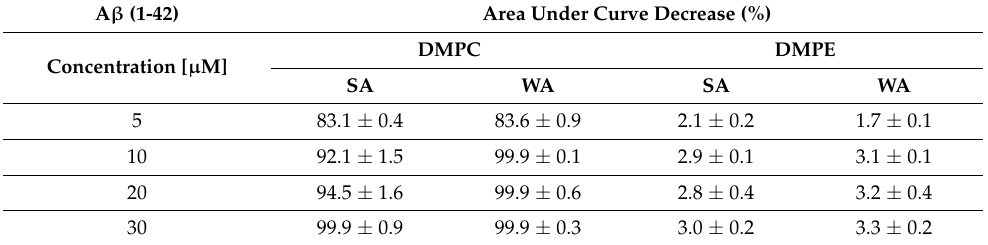
Figure 4. X-ray diffraction patterns of ( A ) dimyristoylphosphatidylcholine (DMPC) and ( B ) dimyristoylphosphatidylethanolamine (DMPE) in water and incubated with A β (1-42); ( C ) DMPC in water, and incubated with AVCRI104P4 and A β (1-42); (SA) small-angle and (WA) wide-angle reflections. Table 2. Decrease in the area under the curve (%) in the (SA) small-angle and (WA) wide-angle reflections of DMPC and DMPE by the effect of A β (1-42). Percentages obtained from the analysis of microdensitograms from the X-ray diffraction patterns of DMPC and DMPE in water and incubated with A β (1-42) solutions.